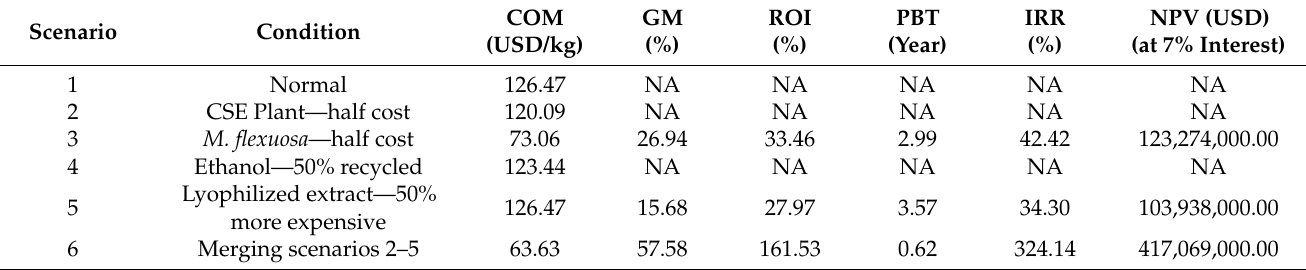
Table 1. Project indices of the single-stage process (CSE).